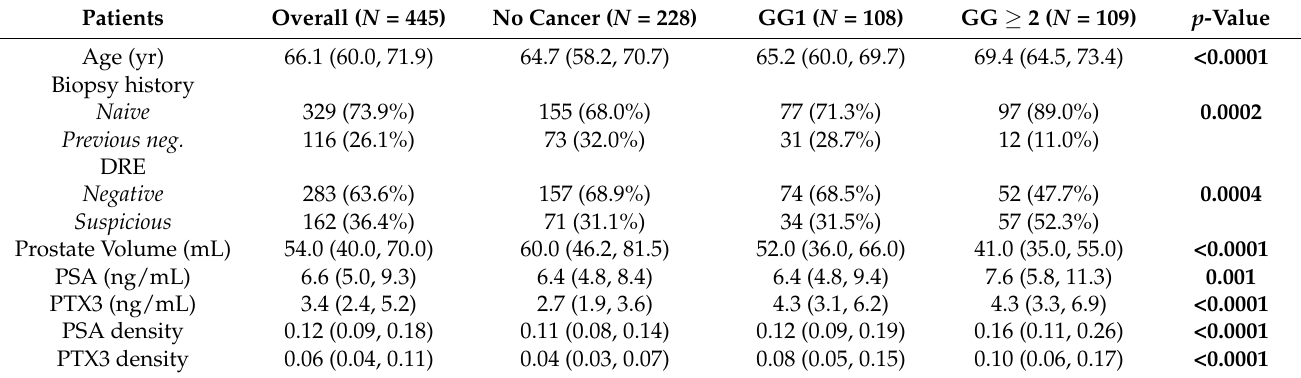
Table 1. Clinical characteristics of the overall population stratified according to biopsy results.